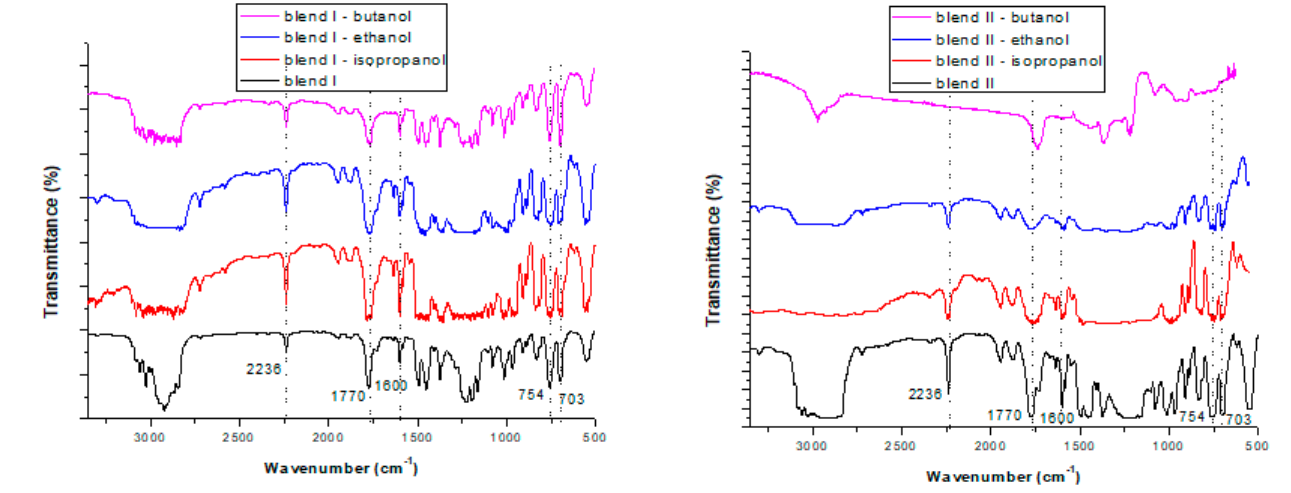
Figure 2. FTIR spectra of the two polymeric blends: blend I ( left ) and blend II ( right ) before pretreatment and after soxhlet extraction for 6 h using different extraction solvents: isopropanol, ethanol and butanol.